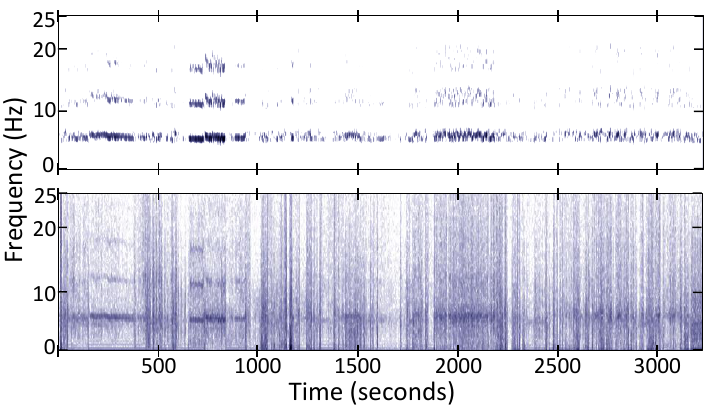
Figure 4. Tremor spectrum ( Top ) extracted from the total spectrum ( Bottom ) of the z -axis acceleration